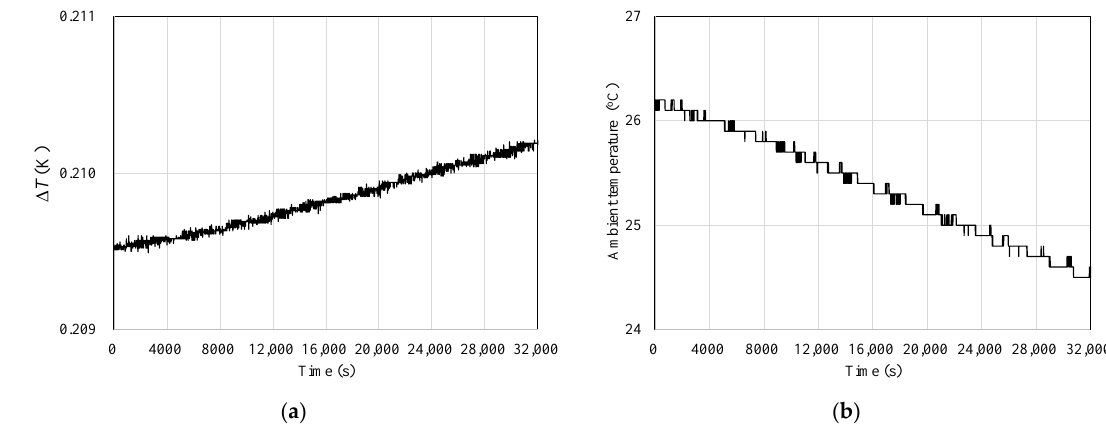
Figure 4. Transient measurement of ( a ) the temperature amplitude of the hot 3 ω heater with EG with decreasing ambient temperature, and ( b ) the measurement of ambient temperature.